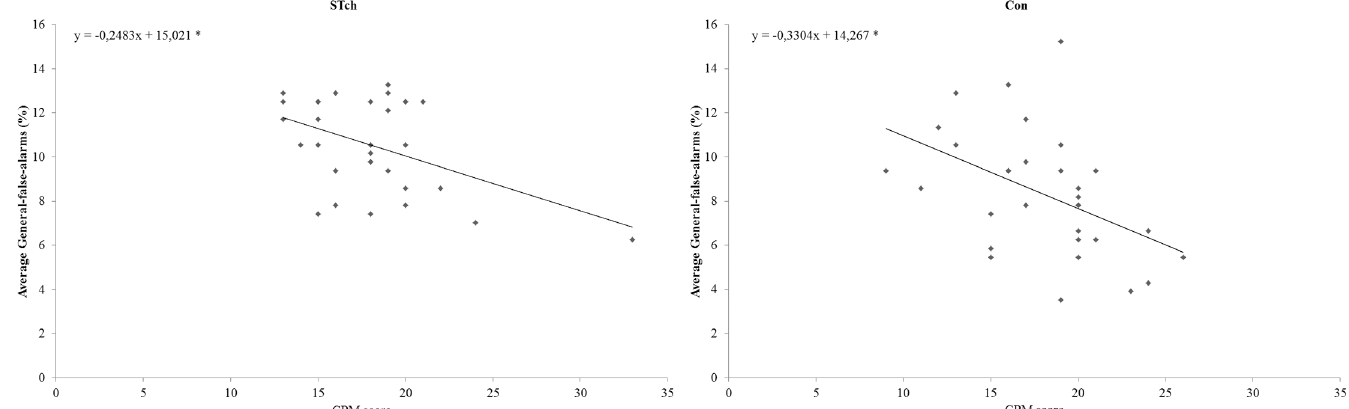
Fig 3. CPM-score predicts average General-false-alarms rate. Plots of CMP-score versus average General-false-alarms for street-children (STch) and controls (Con). * = p <